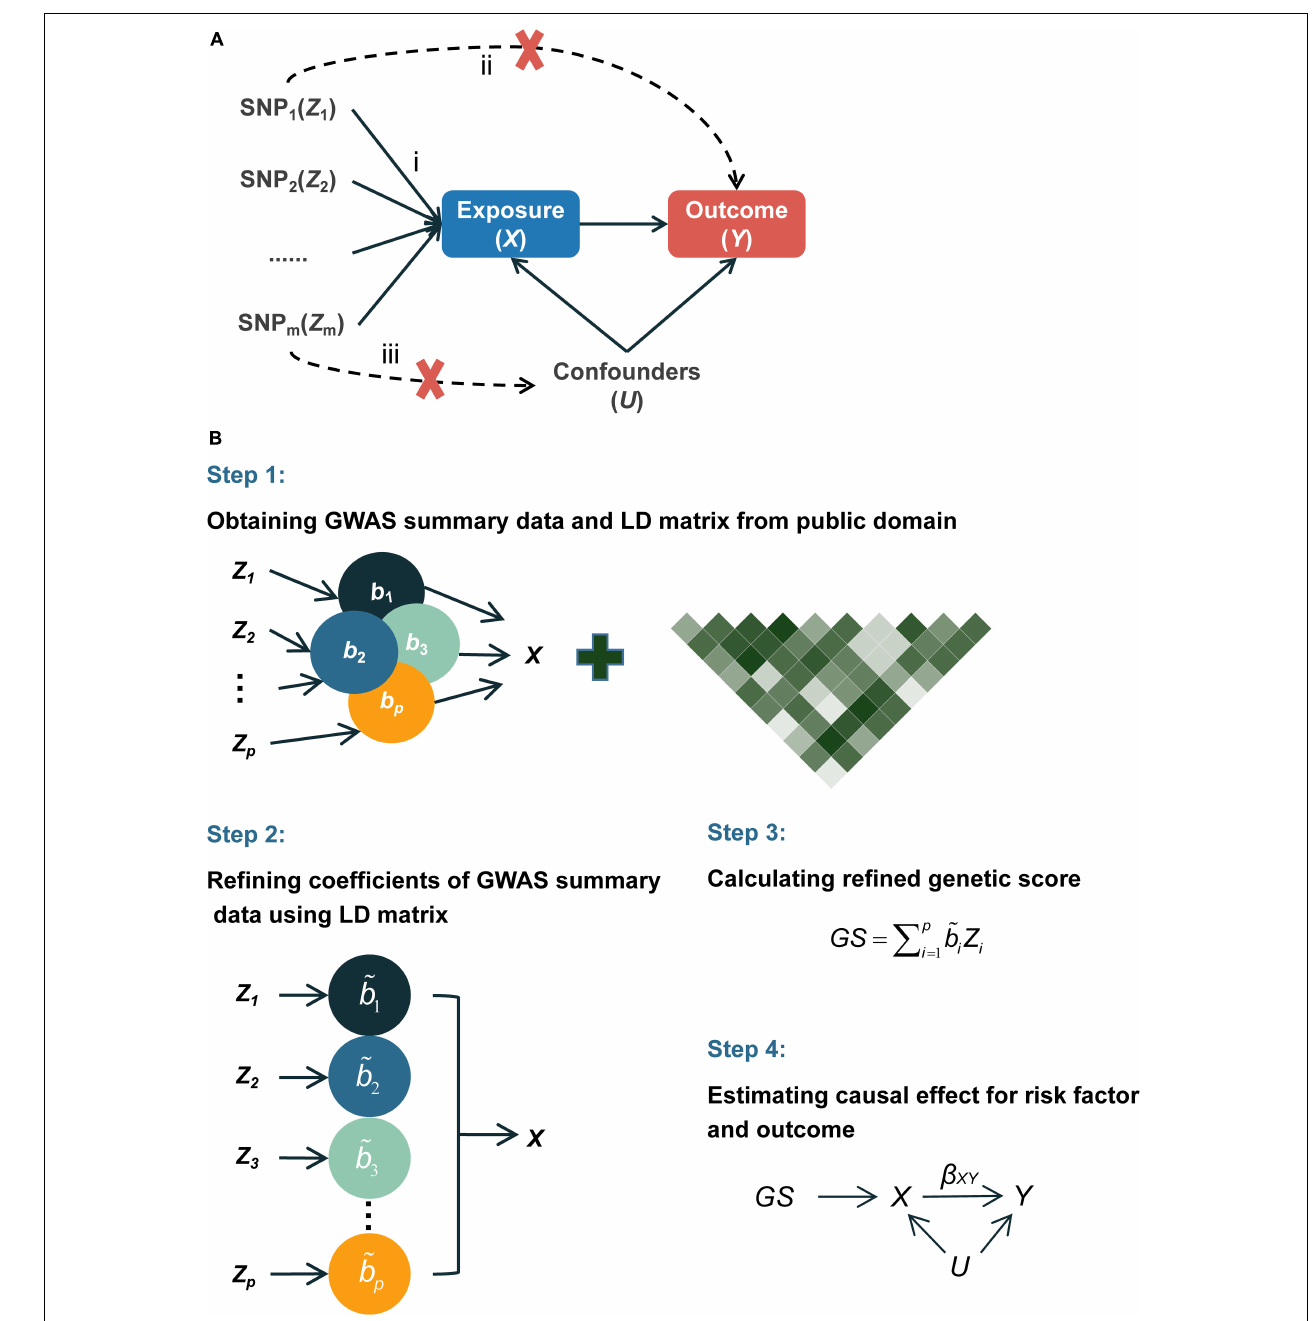
FIGURE 1 | Diagram of Mendelian randomization and flowchart of the proposed MR-RIVER method. (A) Mendelian randomization inferring the causal association of the exposure and outcome: (i) IVs are associated with the exposure X; (ii) IVs and outcome Y are independent, conditional on exposure X and unmeasured confounders U ; (iii) IVs and confounders U are independent. (B) Flowchart of the proposed MR-RIVER method for multiple genetic variants in causal